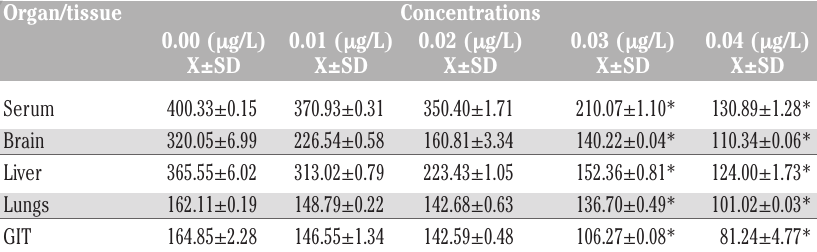
Table 2. Corticosterone levels (ng/mL) in tissues of Bufo regularis exposed to diazinon for 28 days (mean±SD).